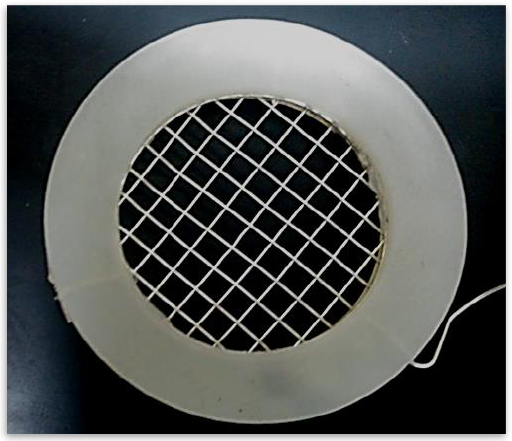
Figure 2. Platinum electrode.